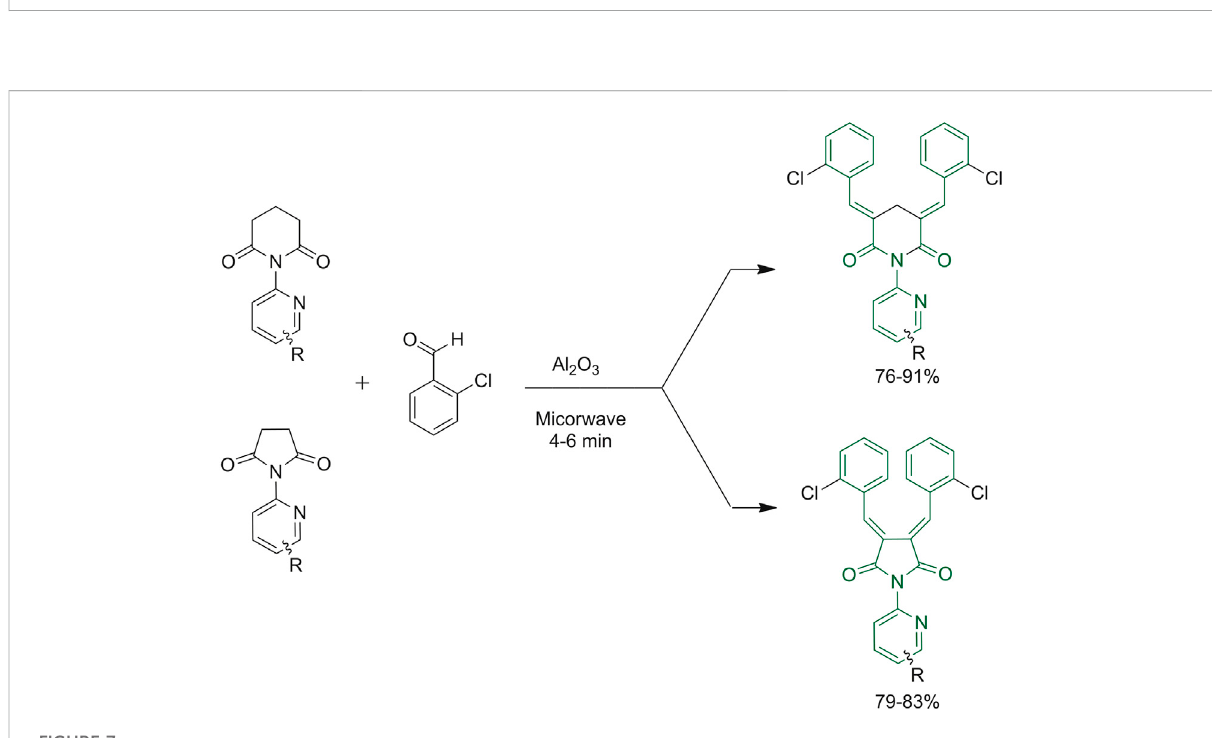
FIGURE 7 Routes to synthesize bischalcone